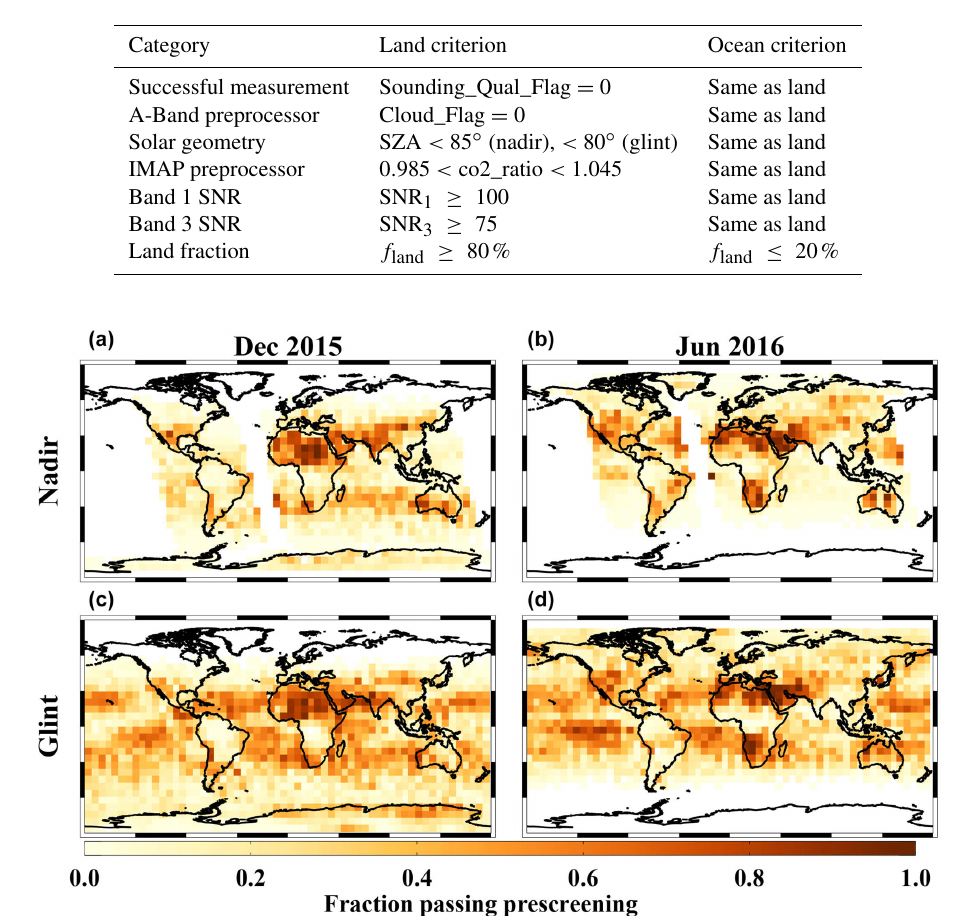
Figure 1. Fraction of soundings passing the OCO-2 B8 prescreening filter in December 2015 (a, c) and June 2016 (b, d) , for both nadir mode (a, b) and glint mode (c, d) . Starting in November 2015, about one-third of all orbits are performed in nadir mode, and two-thirds are performed in glint